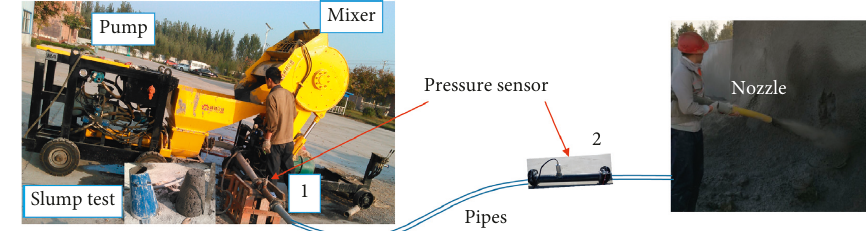
Figure 3: Wet-mix shotcrete test (slump test, pressure measurement, and shotcreting).